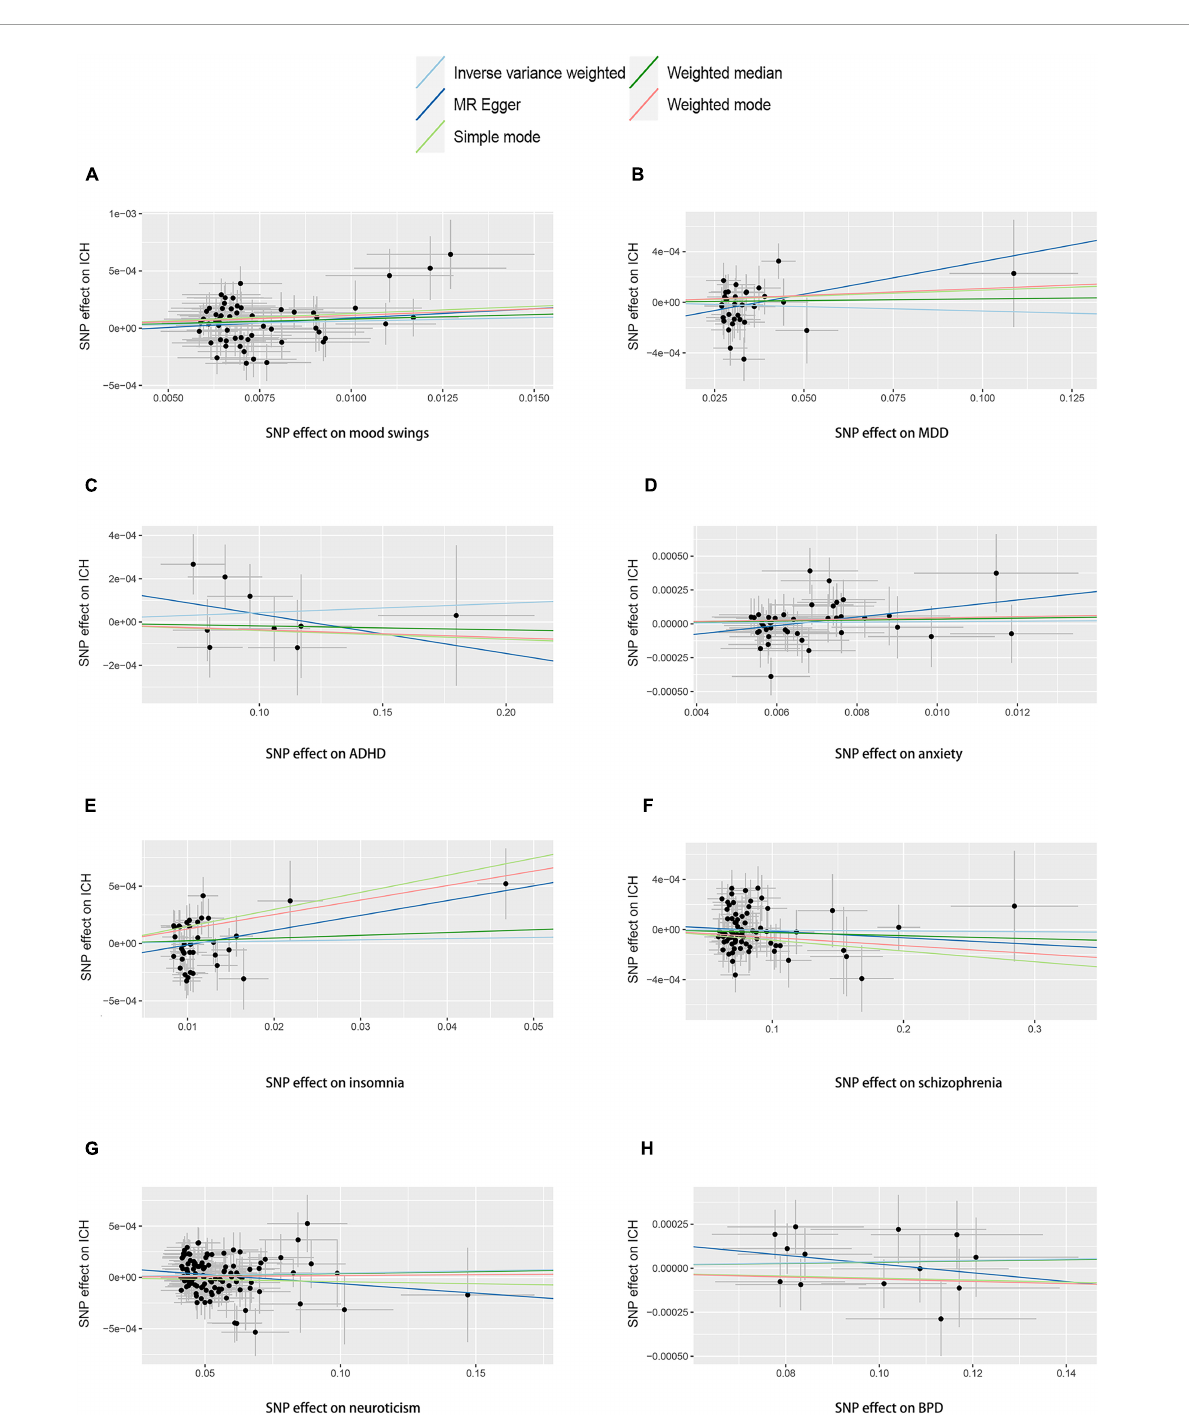
FIGURE3 Scatter plots of group A. Scatter plots of the eight MR results from the eight psychiatric traits related to ICH. Each point in the scatter plot represents an IV. The line on each point reflects the 95% CI, and the horizontal coordinate is the effect of SNPs on (A) mood swings, (B) MDD, (C) ADHD, (D) anxiety, (E) insomnia, (F) schizophrenia, (G) neuroticism, and (H) BPD. The vertical coordinate is the effect of SNPs on ICH. SNP effects were plotted into lines for the inverse-variance weighted test (light blue line), MR-Egger regression (dark blue line), simple mode (light green line), weighted median (dark green line), and weighted mode (pink line). The slope of the line corresponds to the causal estimation. A positive slope indicates that mood swings had a positive effect on ICH. ADHD, attention deficit/hyperactivity disorder; BPD, bipolar disorder; CI, confidence interval; ICH, intracerebral hemorrhage; IV, instrumental variable; MDD, major depressive disorder; MR, Mendelian randomization; SNP, single-nucleotide